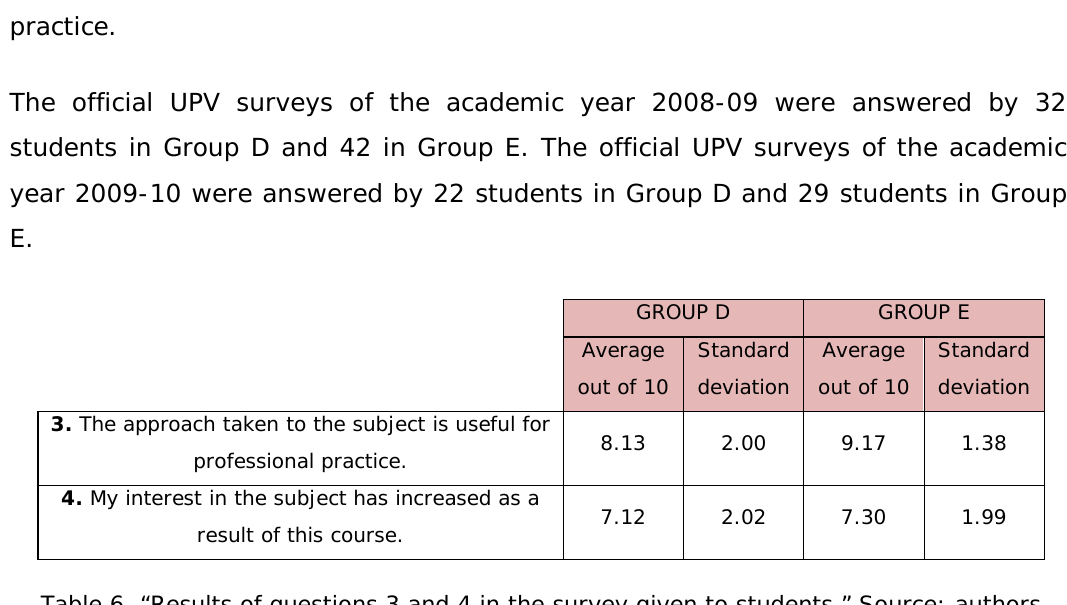
Table 6. “Results of questions 3 and 4 in the survey given to students.” Source: authors